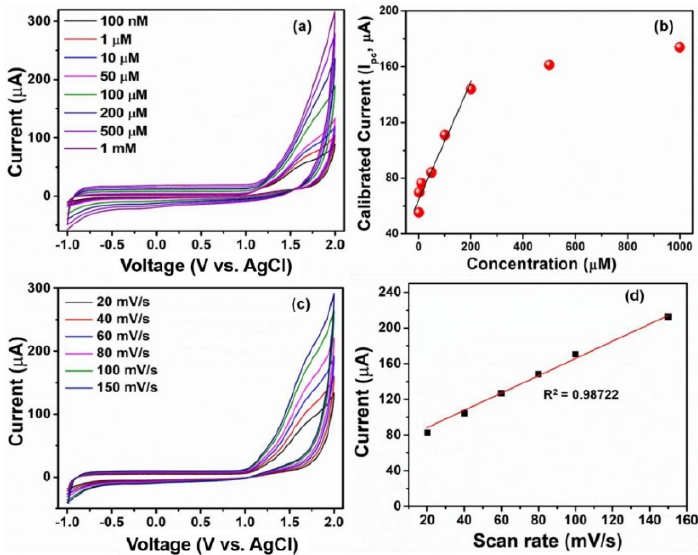
Figure 4. ( a ) CV curves obtained varying the DCM concentrations from 100 nM to 1 mM, ( b ) calibrated current of cathodic peak versus concentration of DCM chemical, ( c ) CV measurements at various scan rates and ( d ) calibrated current at cathodic peak versus scan rate of the hexagonal ZnO NPys modified electrode. Reprinted with permission from ref. [106]. Copyright 2019 Elsevier.